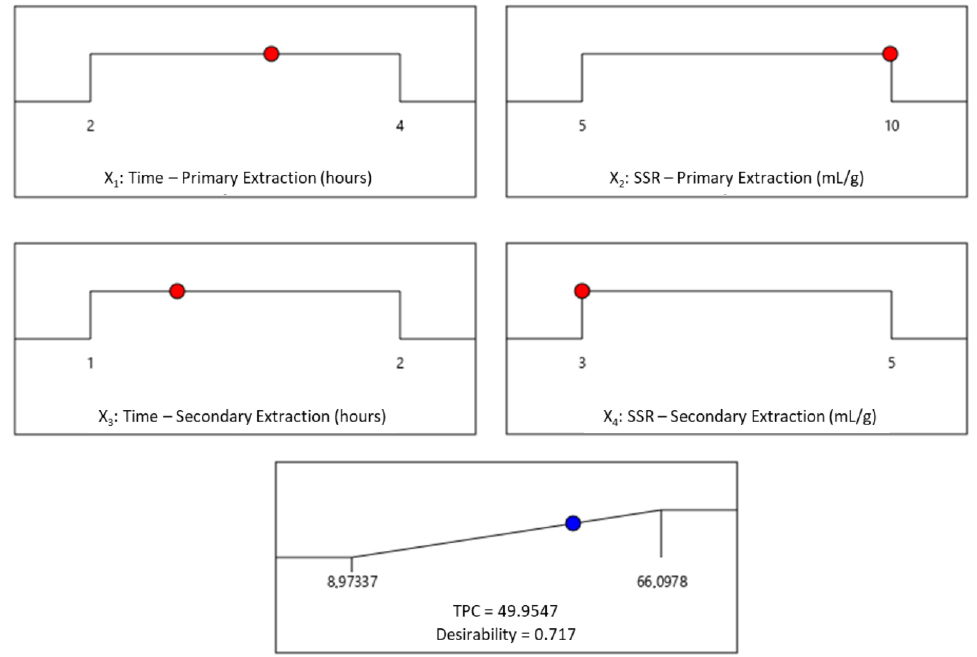
Figure 5. Desirability ramp for the optimization of the two-step extraction of phenolic antioxidants from olive mill pomace ( represent design points; represent a predicted point).